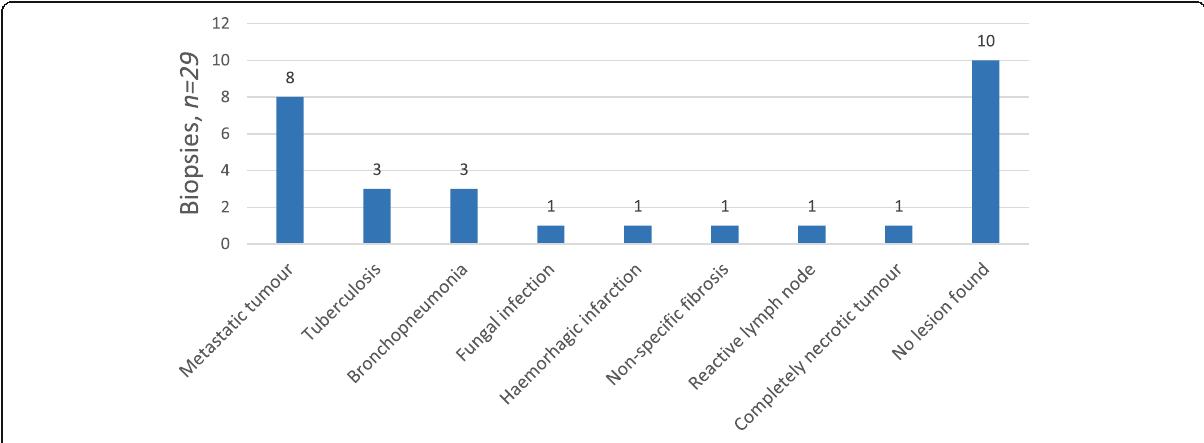
Fig. 2 Histopathologic diagnoses of lesions found on lung biopsy